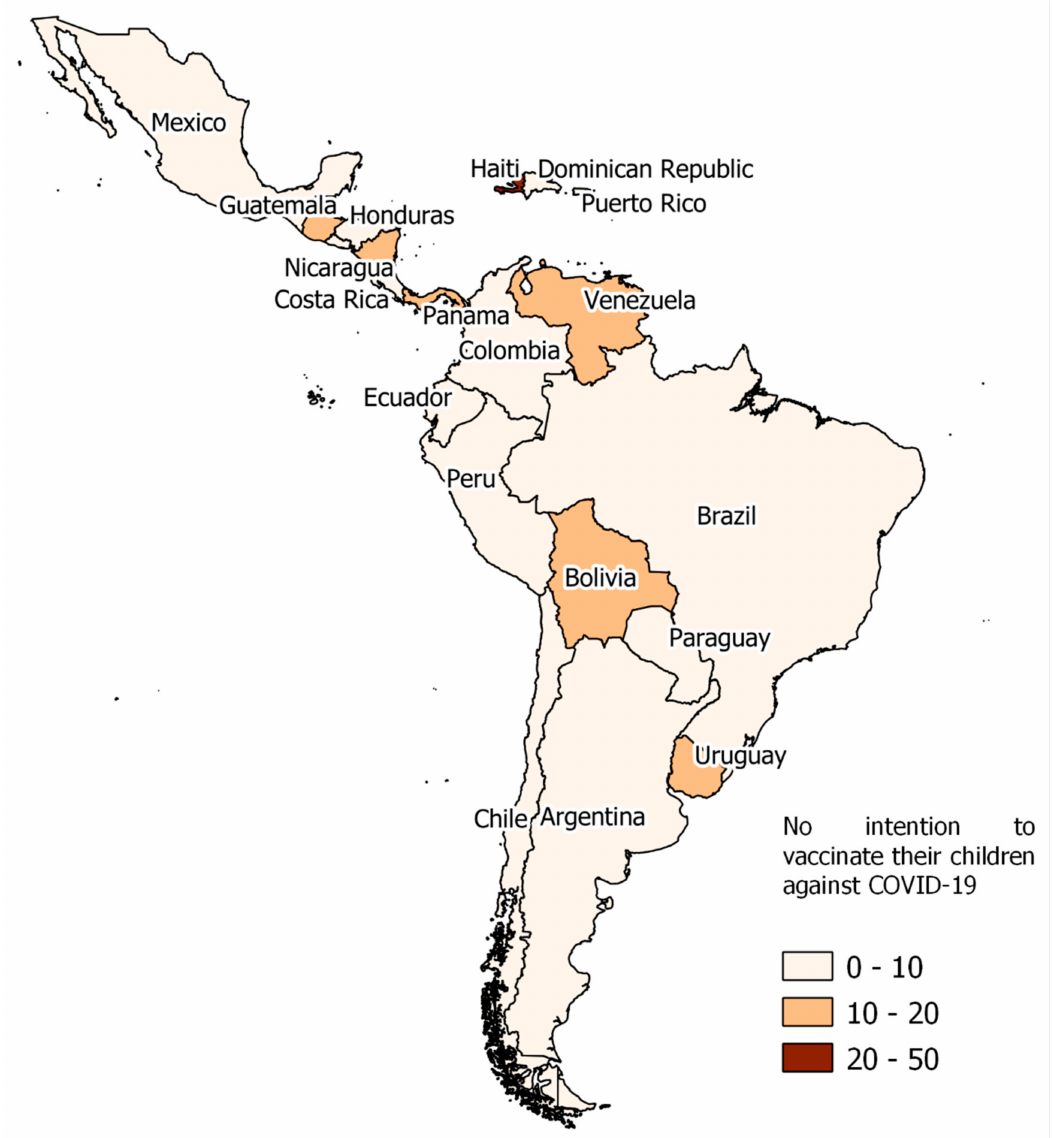
Figure 3. Prevalence of parents’ non-intention to vaccinate their children against COVID-19 in Latin America and the Caribbean